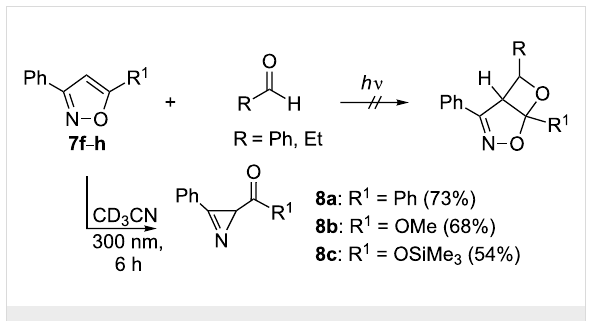
Scheme 4: Photochemical ring contraction of isoxazoles 7f – 7h